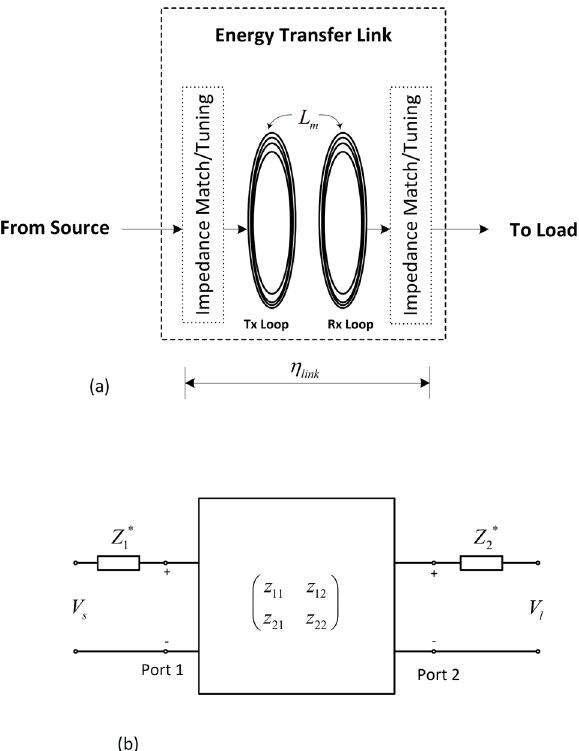
Fig 2. Inductive energy transfer link model. (a) schematic (b) two-port network